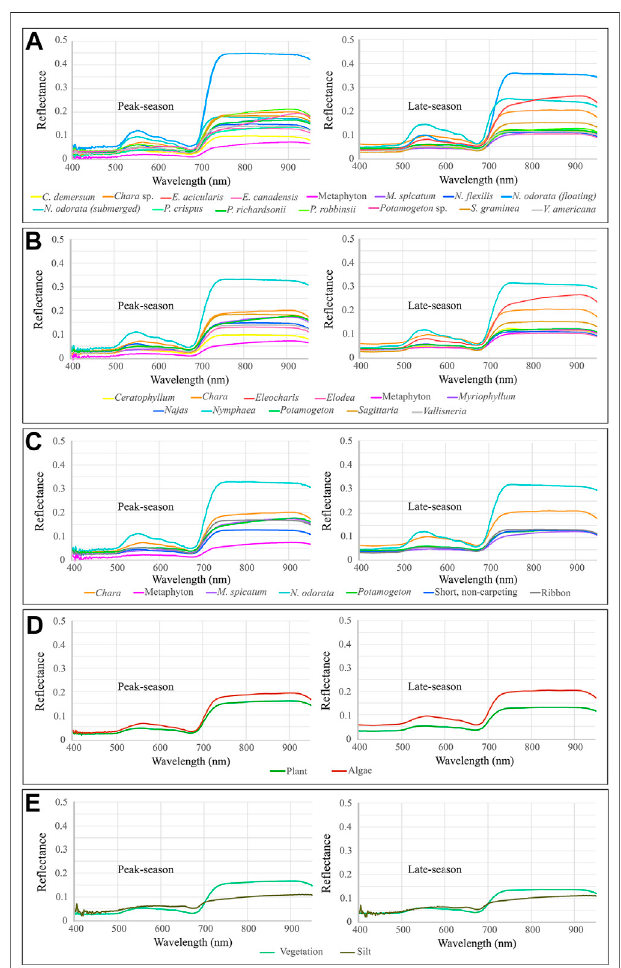
FIGURE 7 | Average spectra of all classes in each grouping scheme for both2019and2020. (A) Allsamplesgroupedbyspecies(a19anda20); (B) All samples grouped by genus (p19 and p20); (C) All samples inad hoc grouping (g19andg20); (D) Allsamplesgroupedbykingdom(alga19andalga20); (E) All vegetation samples plus silt samples grouped as vegetation or non- vegetation (s19 and s20).